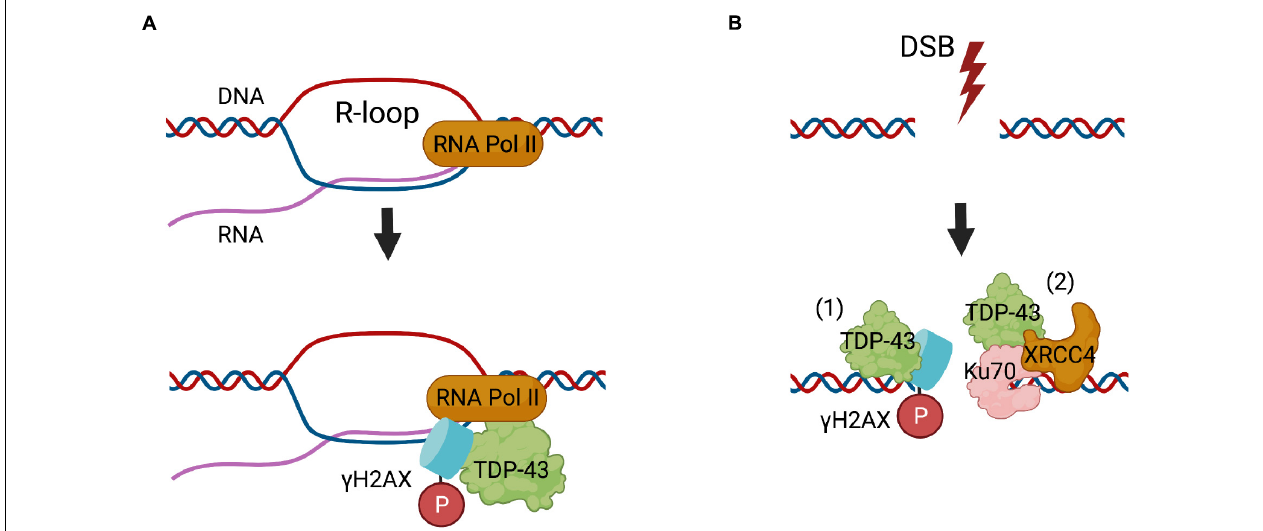
FIGURE 1 | The roles of TDP-43 in DNA repair. (A) TDP-43 functions in the repair of R-loops formed during transcription, where it binds to γ H2AX foci and RNA polymerase II (RNA Pol II). (B) In NHEJ DSB repair, (1) TDP-43 binds to damaged DNA, where it possibly facilitates the phosphorylation of histone H2AX. (2) TDP-43 binds to Ku70 and creates a scaffold for recruitment of the main DNA ligase involved in NHEJ, the XRCC4-DNA ligase IV complex (XRCC4).